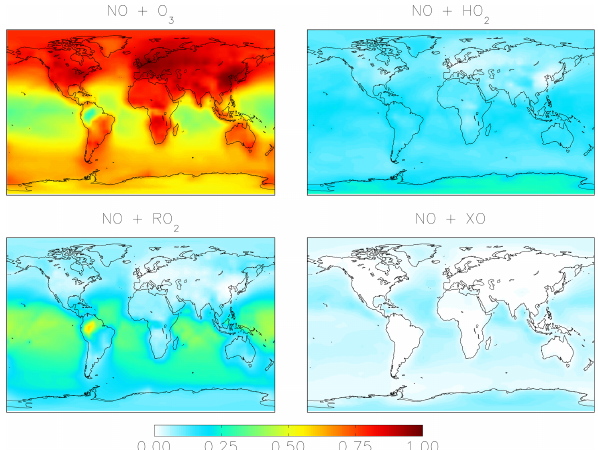
Figure 2. Annual-mean fraction of NO 2 formation from the oxi- dation of NO in the troposphere below 1km altitude in the cloud chemistry